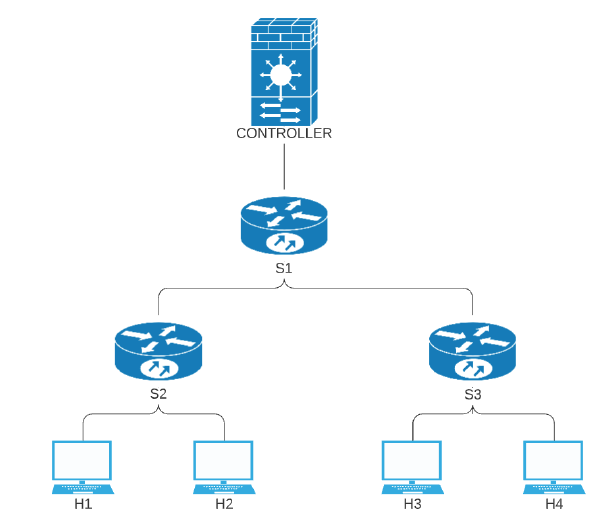
Figure 3. Tree topology.